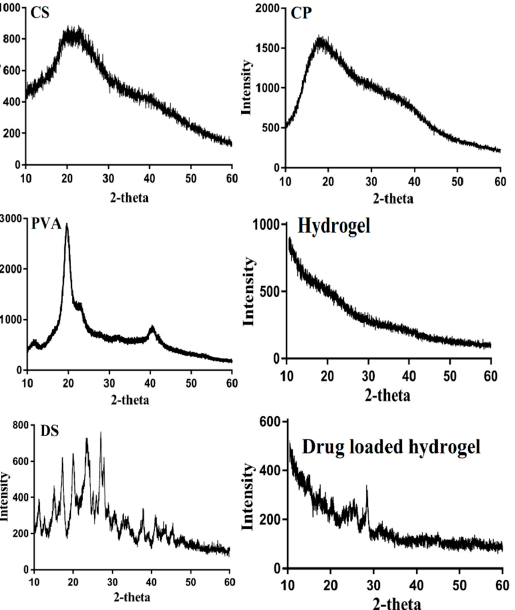
Figure 6. XRD of CS, CP, PVA, CS/CP/PVAcPAa hydrogel, DS, and drug-loaded CS/CP/PVAcPAa hydrogel. 3.6. SEM